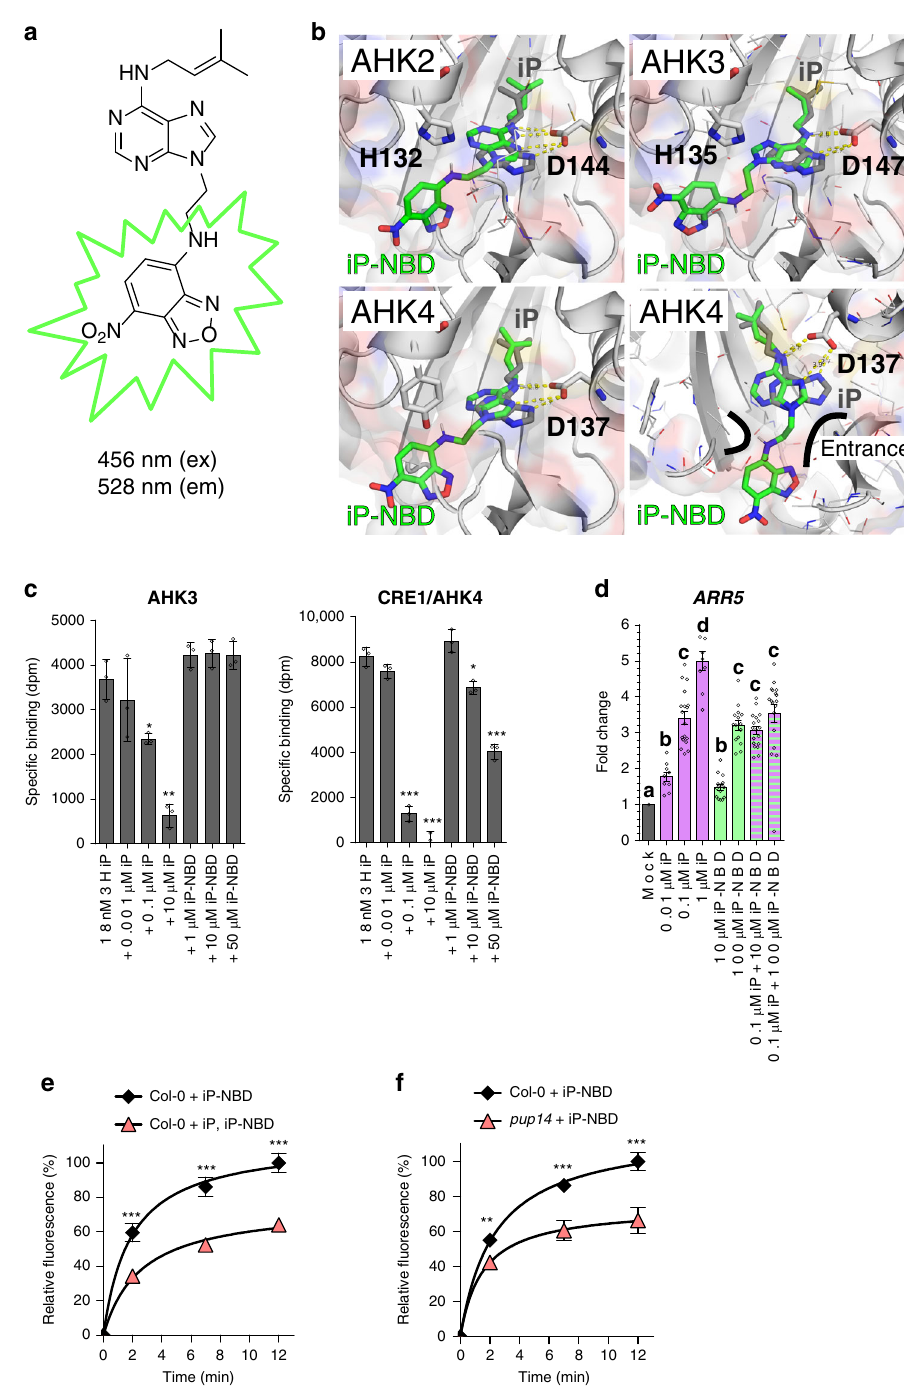
Fig. 1 iP-NBD interacts with cytokinin perception and transport. a Chemical structure of iP-NBD with excitation and emission wavelengths b Superposition of docking simulation of iP-NBD (in green) and natural ligand iP (in grey) in AHK2, AHK3 (upper row) and CRE1/AHK4 (left panel of lower row) receptor cavity showing the embedded position of the ligands. CRE1/AHK4 (right panel of lower row) with visualized entrance channel and the fl uorophore fi tting into an antechamber through the ethylene linker. c Competitive binding assay with Escherichia coli expressing AHK3 and CRE1/AHK4. Binding of [2- 3 H]iP (18 and 6 nM in the case of AHK3 and CRE1/AHK4, respectively) was assayed together with increasing concentrations of unlabelled iP and iP-NBD. The bars represent mean ±s.d., *** p < 0.001, ** p < 0.01, * p < 0.05; n = 3 (Student ’ s t test). d Expression of the early cytokinin response gene ARR5 in 5-day-old seedlings of Col-0 treated with 0.01 µ M iP, 0.1 µ M iP, 1 µ M iP, 10 µ M iP-NBD, 100 µ M iP-NBD or co-treatments of 0.1 µ M iP + 10 µ M iP-NBD, 0.1 µ M iP + 100 µ M iP-NBD or DMSO for 15 min (mean ±s.d., p < 0.05 by two-way ANOVA. n = 9 – 18; three technical replicates from three biological replicates per condition). e Kinetics of 5 µ M iP-NBD uptake in Arabidopsis LRC cells of wild type (Col-0) pre-treated with 5 µ M iP. f Kinetics of 5 µ M iP-NBD uptake in root meristem epidermal cells of wild type (Col-0) and pup14 . iP-NBD fl uorescence was measured in four time points (0, 2, 7 and 12min). The bars represent mean± s.d., *** p < 0.001, ** p < 0.01; n ≥ 20 (Student ’ s t test) ( e , f